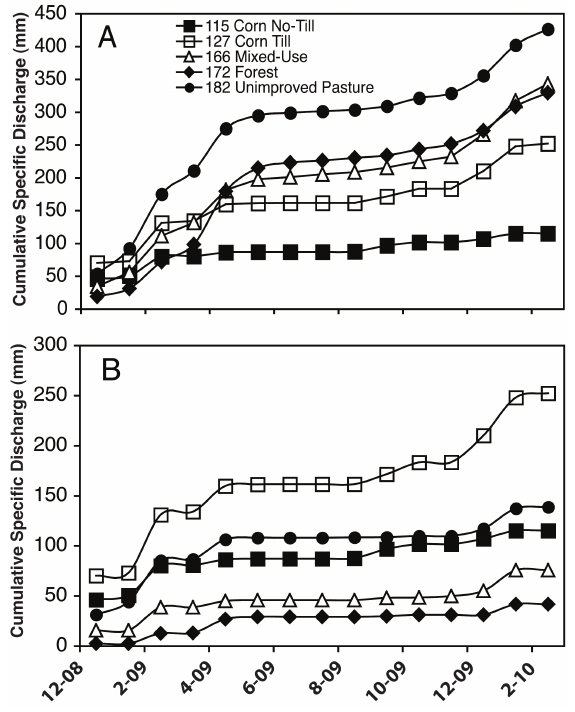
Fig. 3. Cumulative specific discharge (mm) for (A) total flow and (B) stormflow from December 2008–February 2010 for NAEW wa- tersheds.